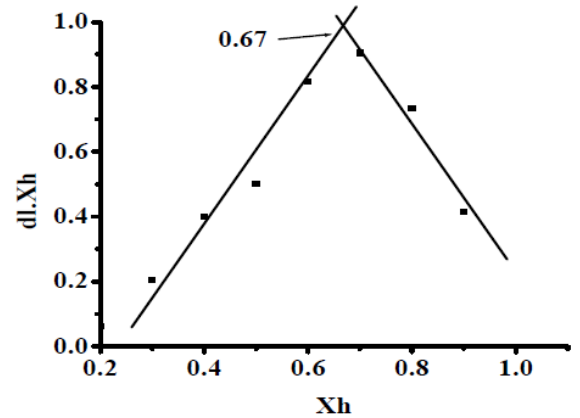
Figure 26: Jobs plot diagram of receptor R 34 for anion tetrabutylammonium acetate (where Xh is the mole fraction of host and dI indicates the change of the absorbance).